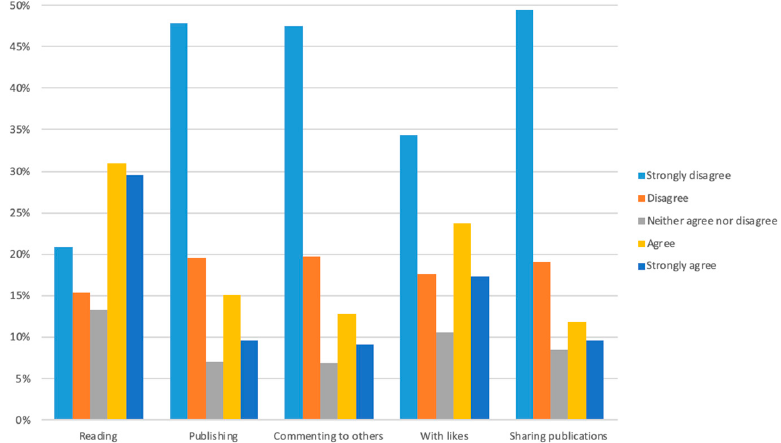
Figure 8. Participation in Facebook group: reading, publishing, commenting, likes, and sharing (Q4).